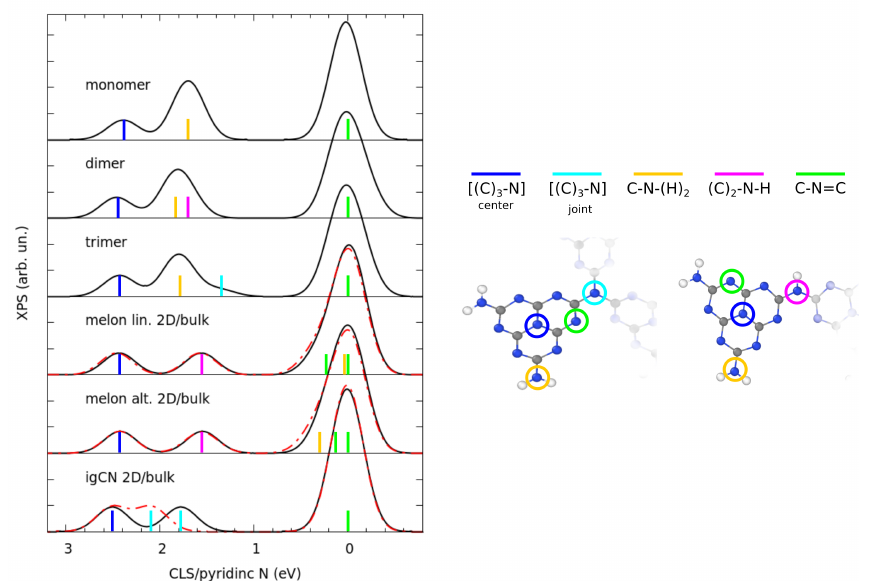
Figure 5. Comparison of XPS spectra calculated for different models of gCN and melem aggregates. Solid black lines or dash-dot red lines report spectra of 2D or bulk structures, when available. CLSs calculated aligning the position of pyridinic N atoms to the origin. The position of the contributions from inequivalent N atoms is marked on the spectra through colored